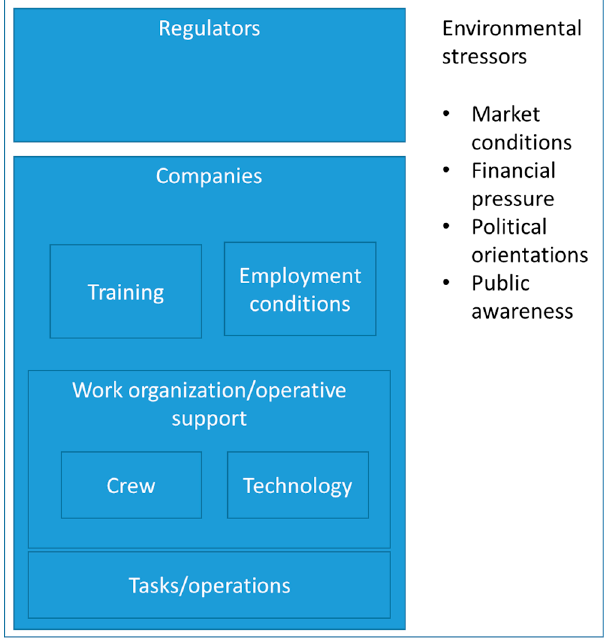
Figure 1. Defined organizational components and environmental stressors (adapted from [4]).